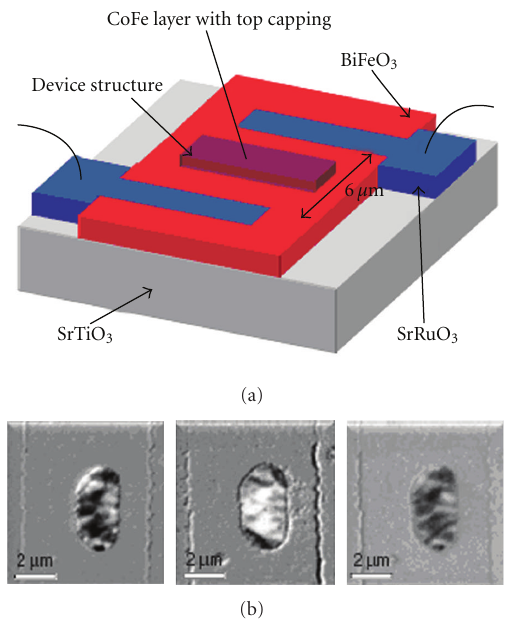
Figure 6: (a) Schematic diagram of device that would allow controlled ferroelectric switching in BFO layer and electrical control of ferromagnetism in the CoFe layer, and (b) XMCD-PEEM images acquired at Co L edge showing the ferromagnetic domain of CoFe layer in the as grown, after first electrical switching and after second electrical switching. Figures were reproduced with permission from Chu et al.